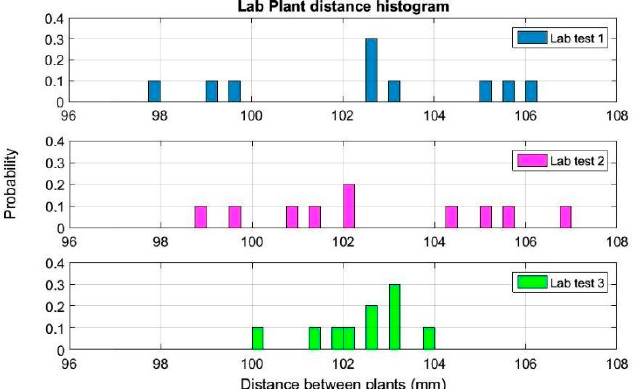
Figure 7. Histogram of measured distances between 3d plant stems during the adjusting process of sensors on the detection platform in the laboratory.